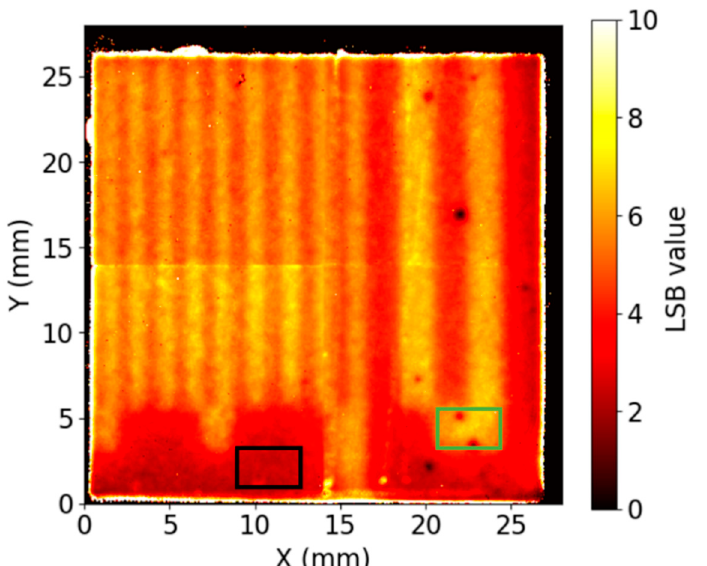
Figure 12. Heat map for 30 kV X-rays using a line pair mask type 53 as an imaging target in front of the GEMPix. For the normalization factor C0 in Equation (2), two regions were selected: the green rectangle on top of the first bar for the maximum pixel intensities and a black rectangle on the bottom part of the mask for the minimum.